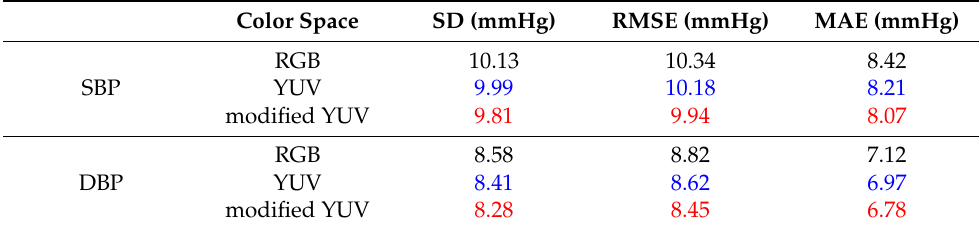
Table 1. Comparison of the performance of different color